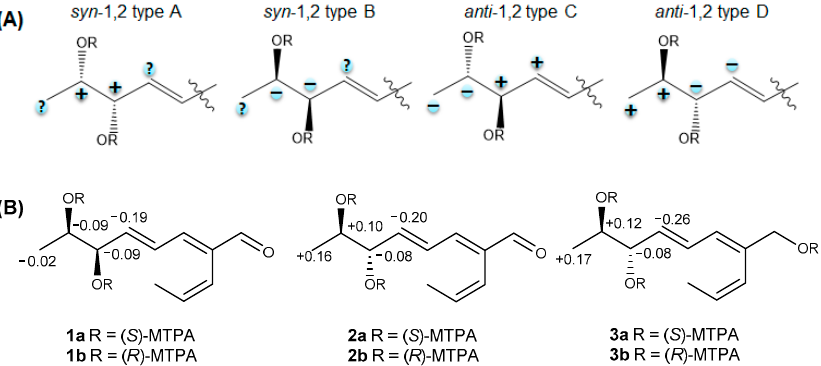
Figure 3. ( A ) Sign distribution ( Δδ S − R ) of bis-MTPA esters of the four possible stereoisomers of 1,2-diols [16]; ( B ) Δδ S − R values of 1a − 3b in CD3OD.